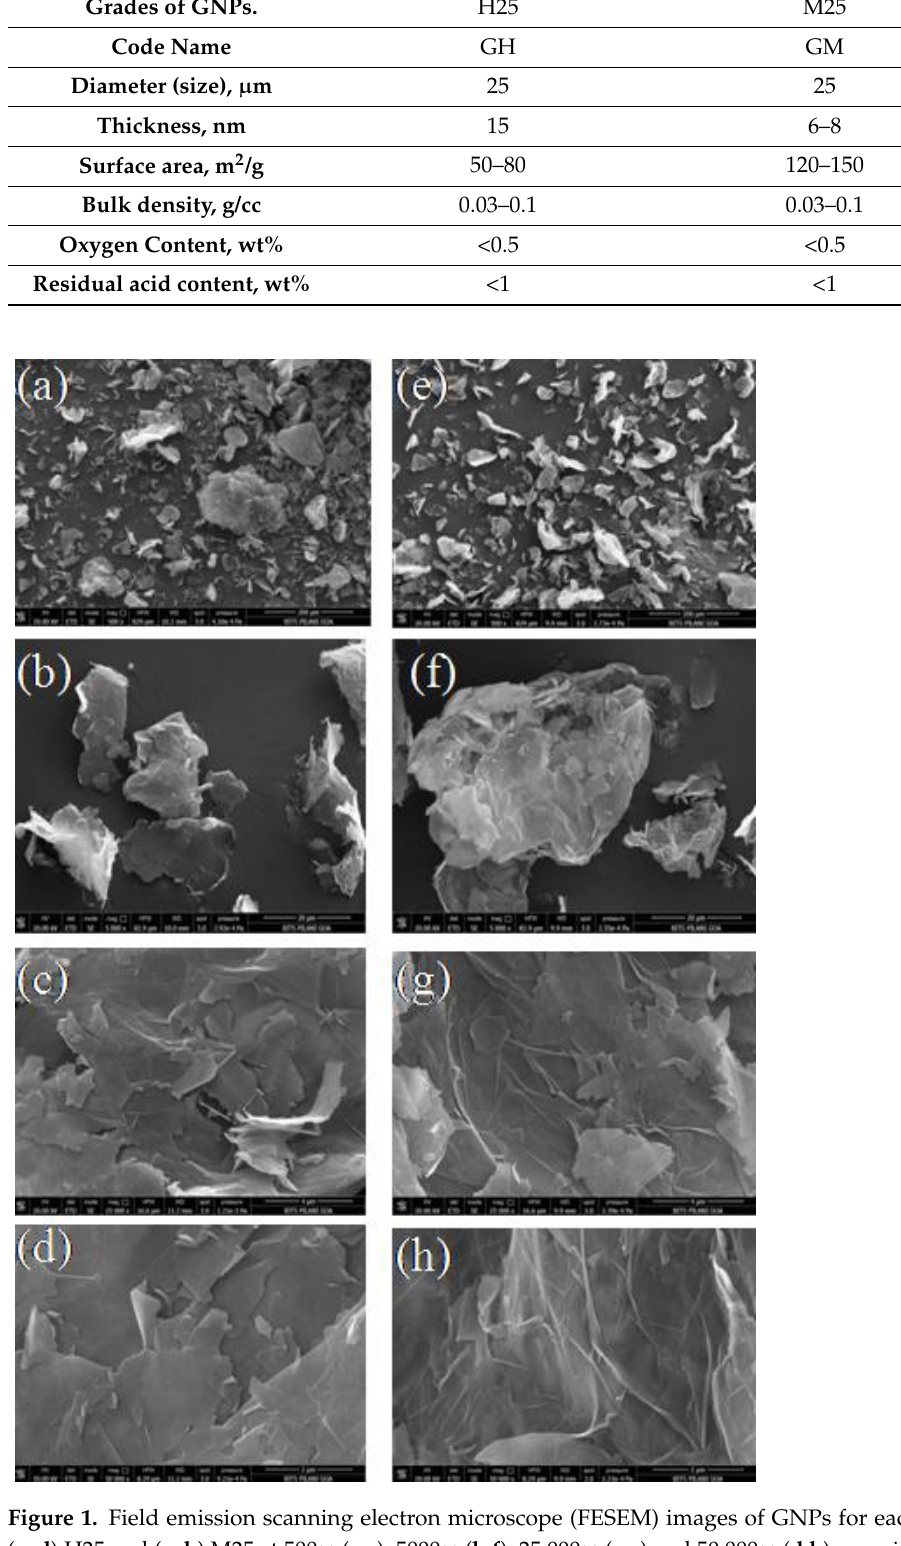
Table 1. Typical properties of the procured GNPs. Grades of GNPs.